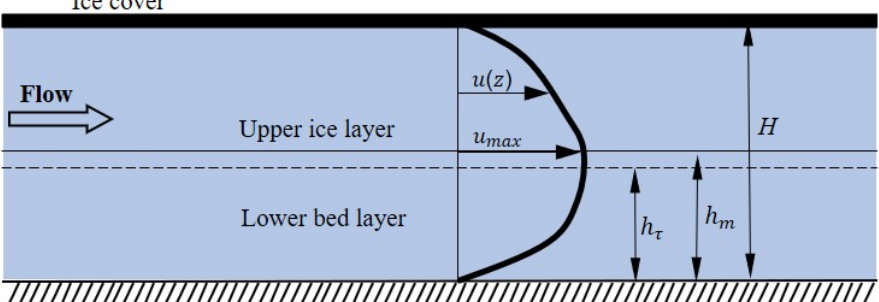
Figure 1. Schematic profile of the longitudinal velocity in an iced-covered open channel.